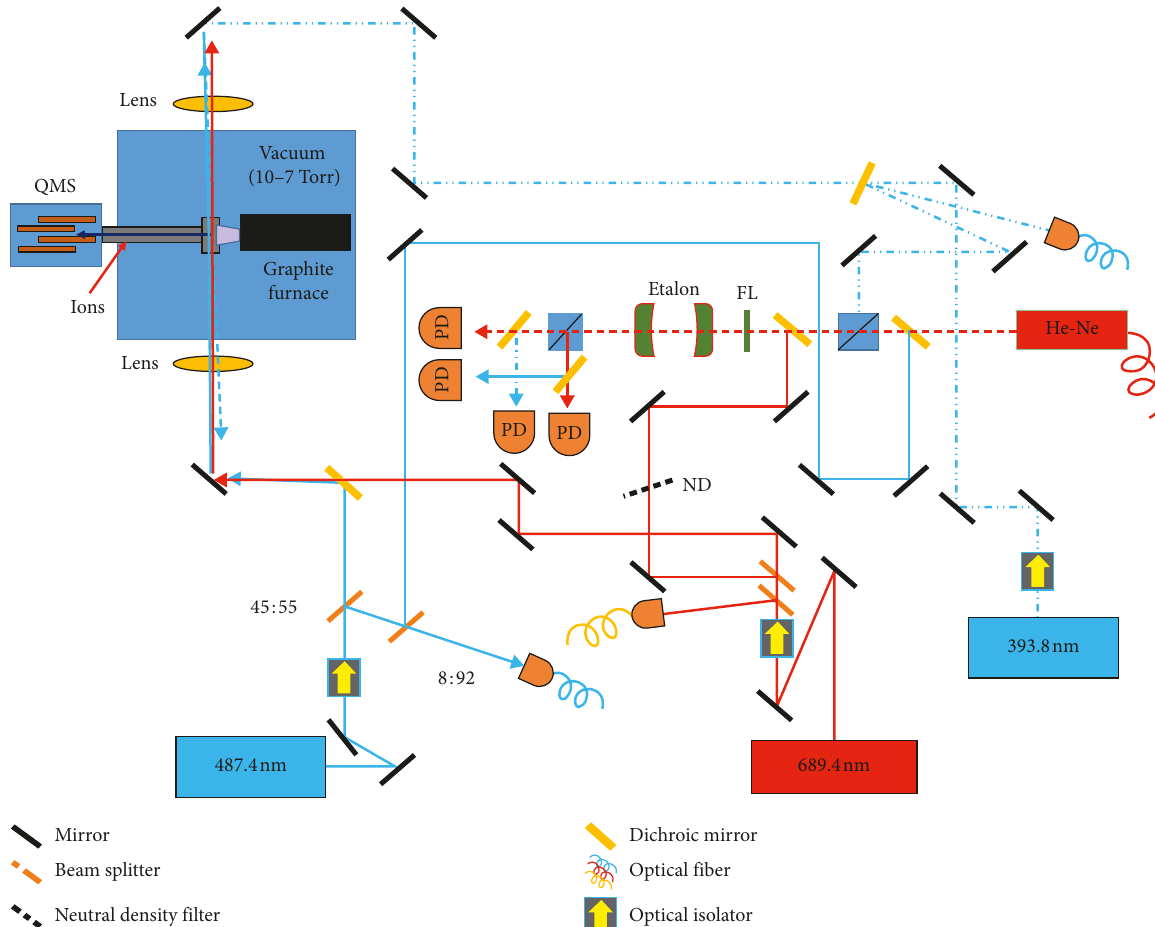
Figure 2: Experimental setup for the three-step resonance ionization 689.4 nm-487.4nm-393.8nm.